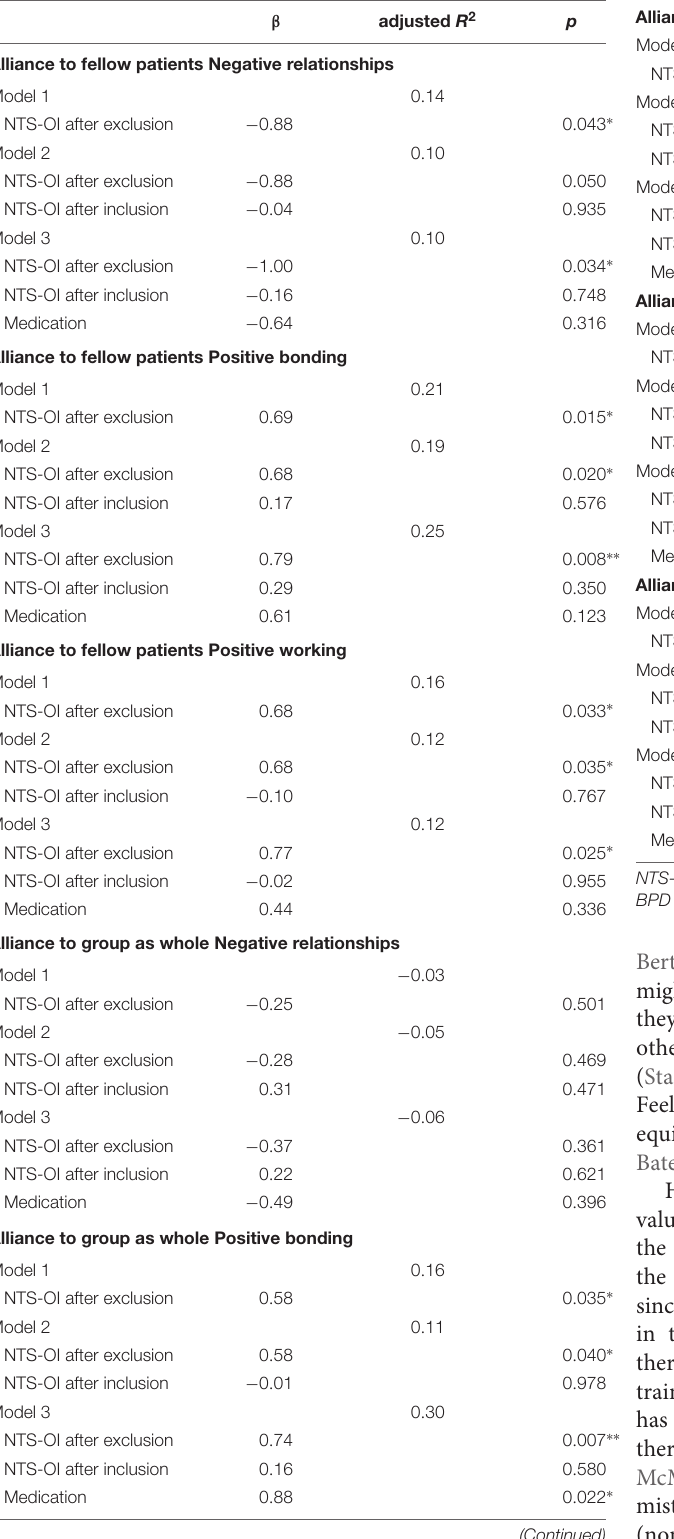
TABLE 4 | Multiple Regression Analysis of Group Questionnaire (GQ) and NTS-OI after exclusion Cyberball condition controlling for inclusion condition and medication in BPD group ( n =